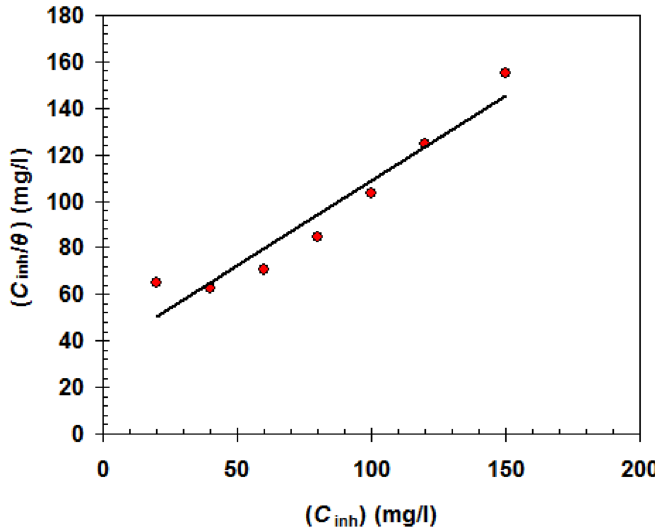
Figure 7. Langmuir isotherm plot for N80 C-steel pipe in 15.0% HCl solution containing 100 mg/l DMAEB at 303 K.